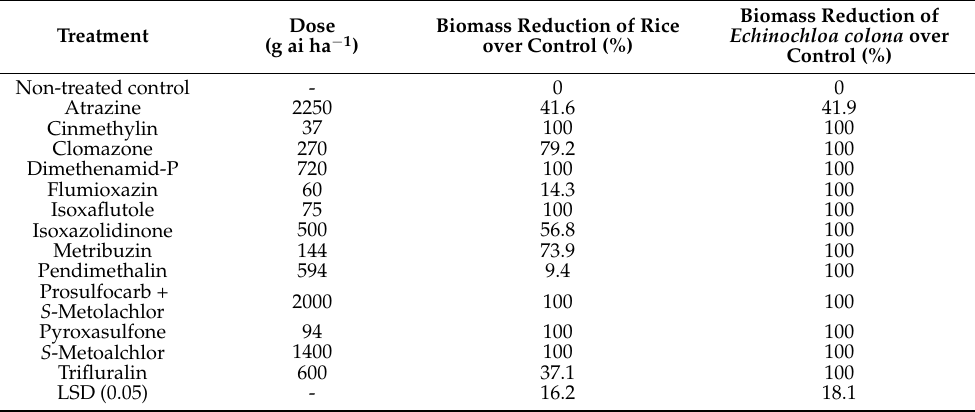
Table 1. Effects of pre-emergent herbicides on rice and Echinochloa colona biomass.